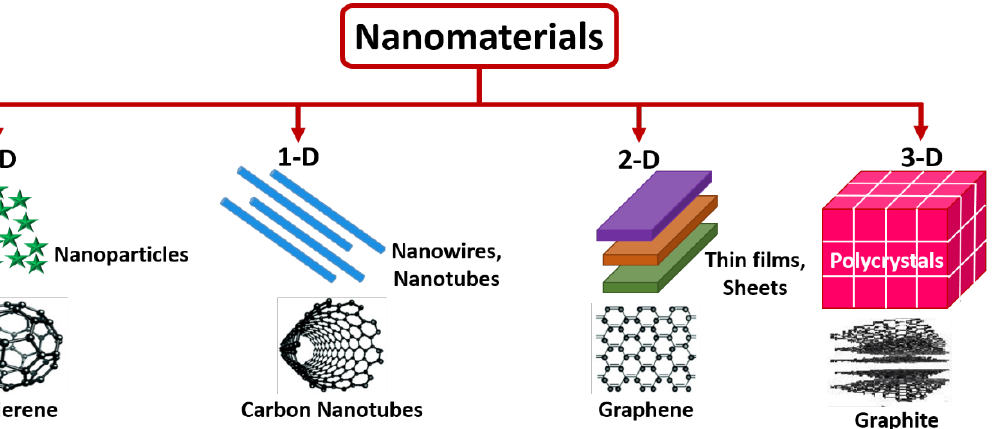
Figure 1. Schematic of 0-D, 1-D, 2-D, and 3-D, nanostructured